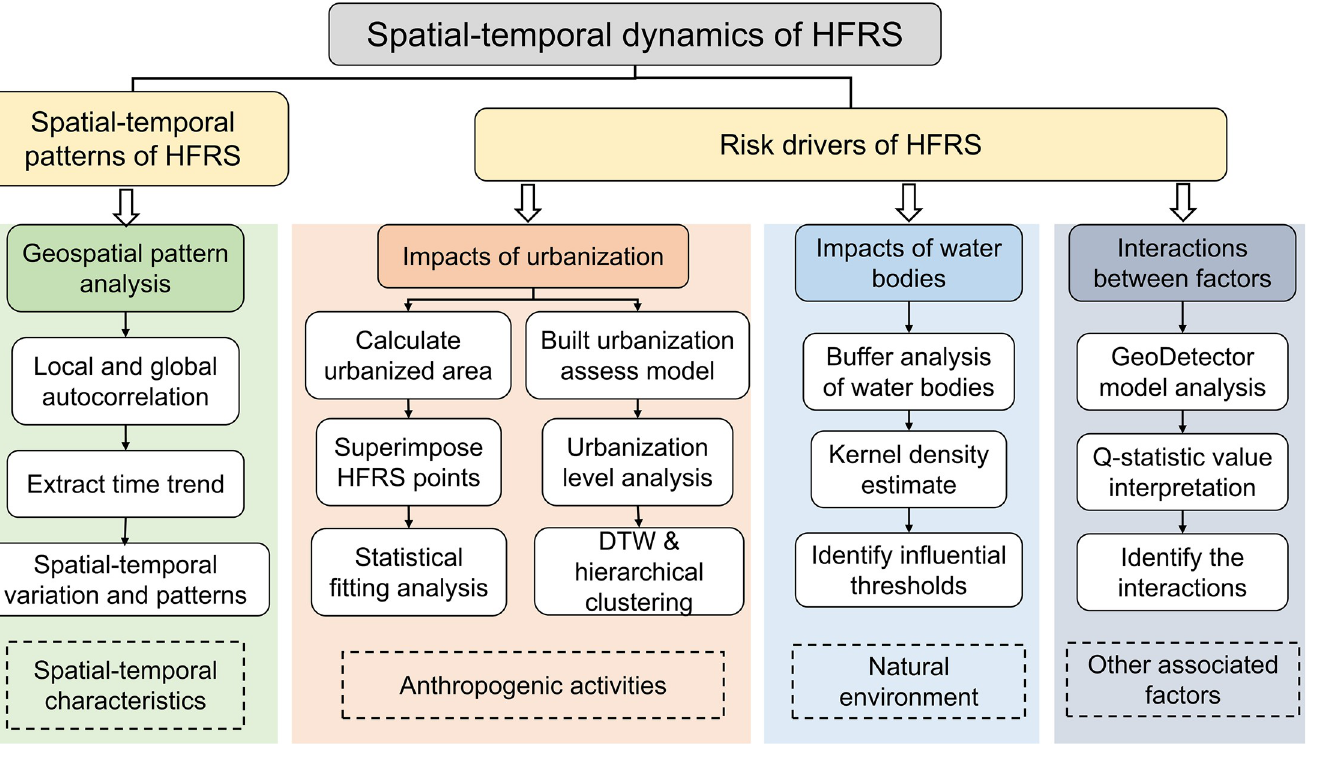
Fig 2. Overall methodology